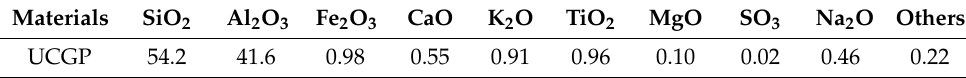
Figure 2. UCGP particle size distribution. Table 1. Chemical composition of UCGP (wt %).